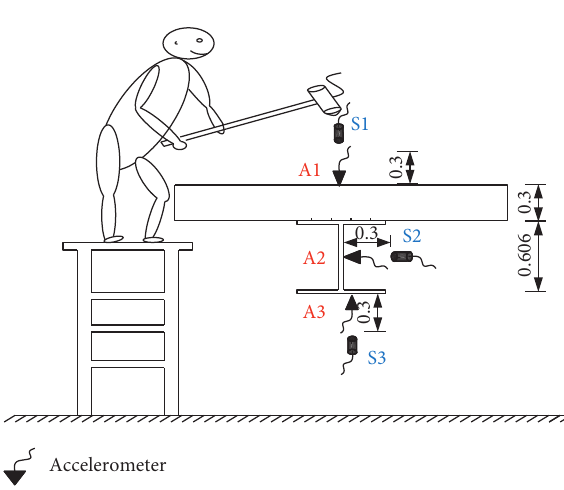
Figure 3: Schematic representation of the hammering test and measuring point